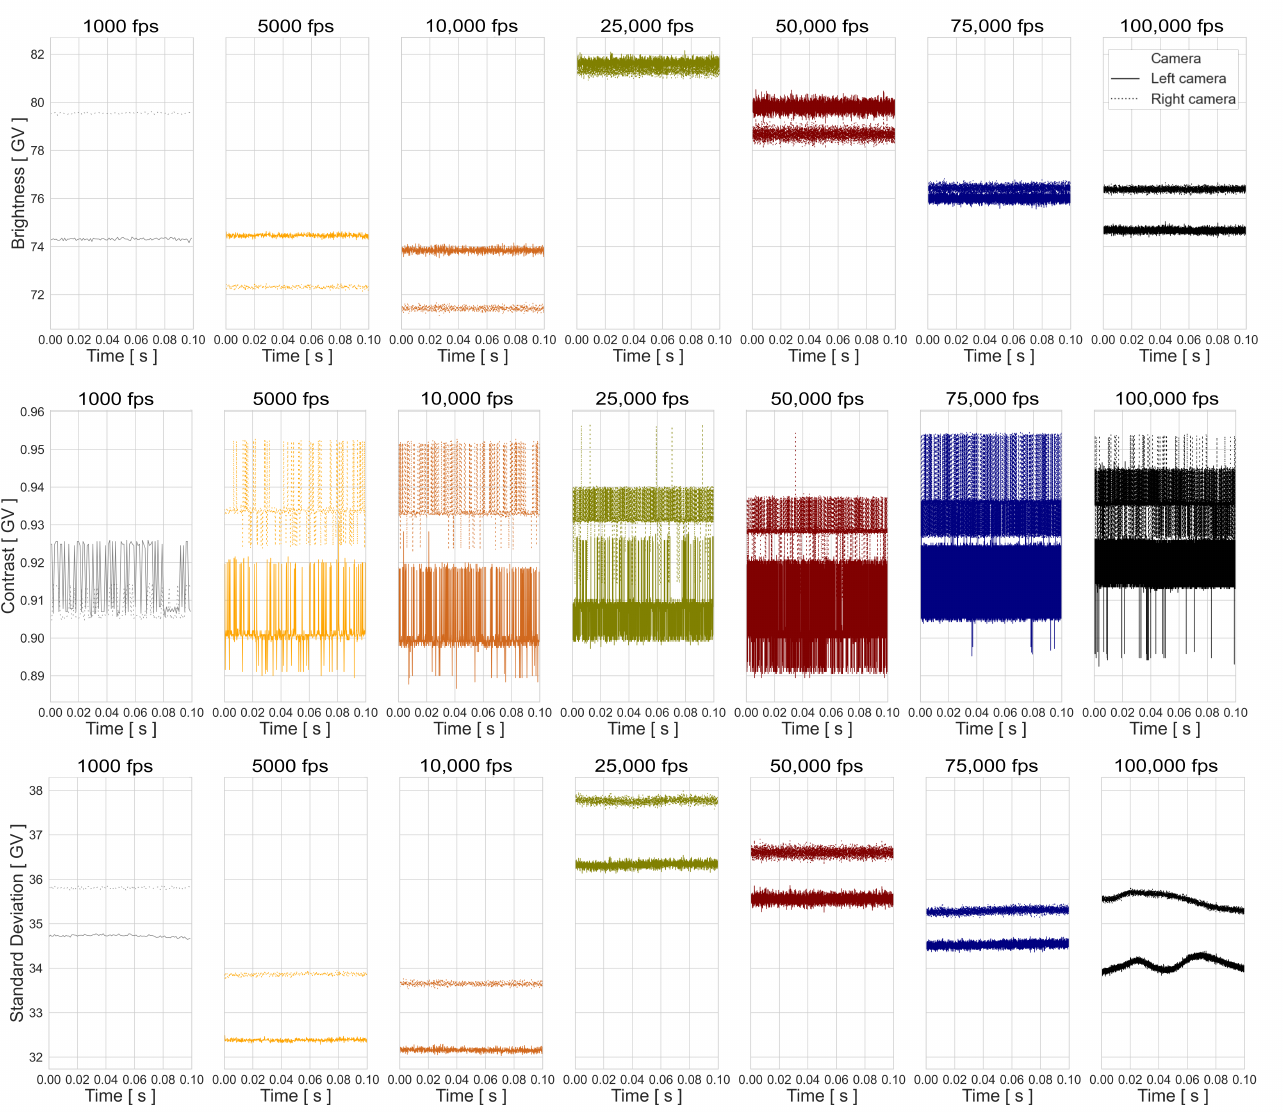
Figure A3. B P , C P , and Std P of images used for the experiment configurations: Static, 01 calibration, and RP